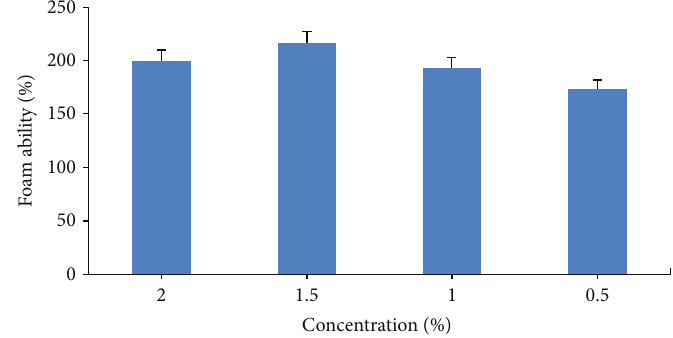
Figure 4: Foaming ability of di ff erent pectin concentration isolated from in vitro cultures of Fumaria o ffi cinalis .